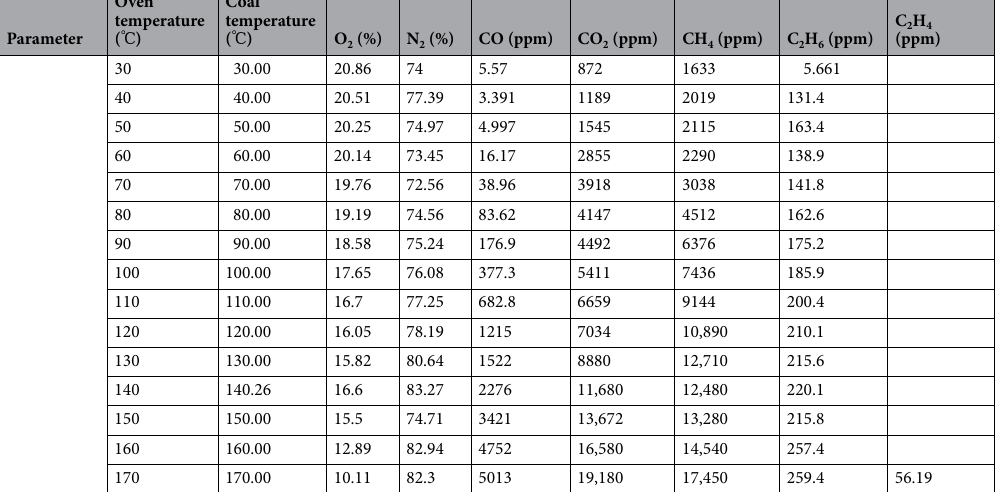
Table 4. Data obtained from the TPO